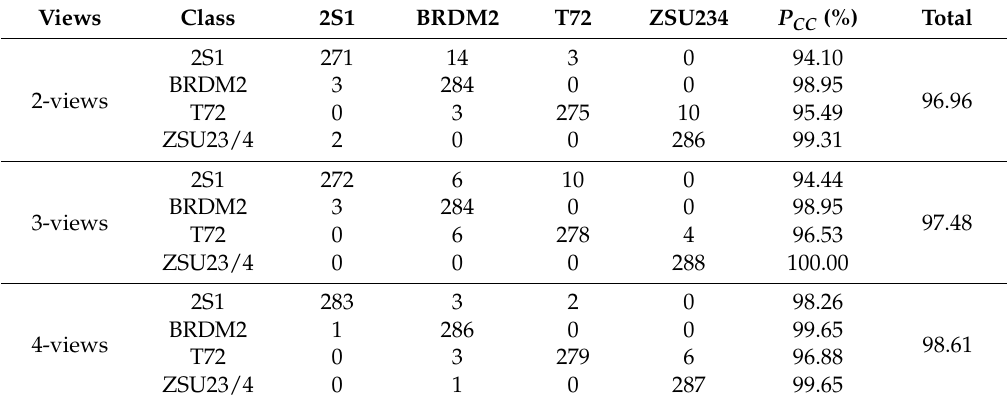
Table 7. Confusion matrix of the MS-CNN under EOC-1 (large depression angle).